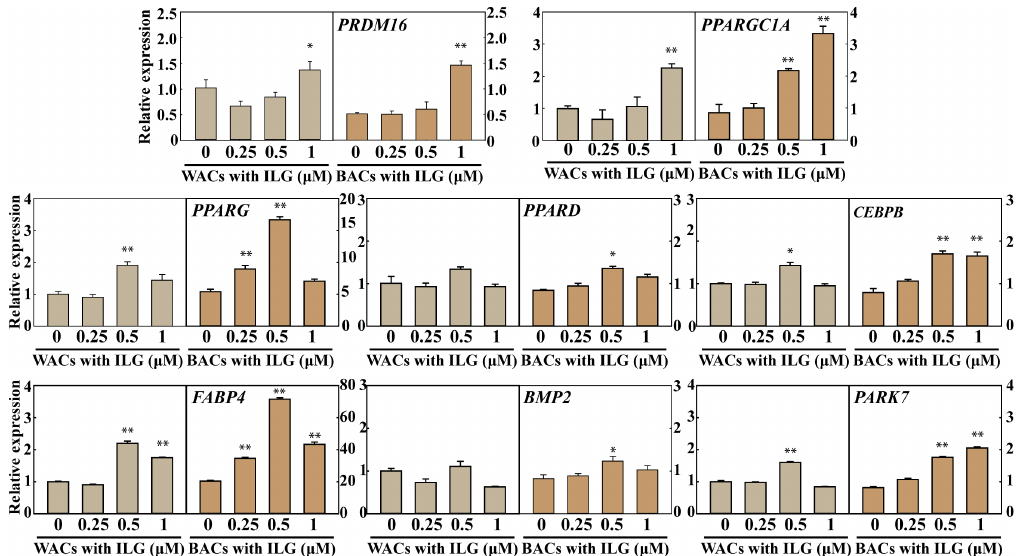
Figure 3. E ff ect of ILG treatment on the mRNA expression of browning markers in WACs and BACs. E ff ect of ILG treatment on the mRNA expression of browning markers in WACs and BACs. Quantitative real-time PCR analysis of the PPARGC1A , PPARG , PPARD , CEBPB , FABP4 , BMP2 , and PARK7 genes in cells treated with ILG for 24 h after adipogenic di ff erentiation. GAPDH was used as an internal control to normalize the expression of the target genes; n = 3 independent experiments; * p < 0.05 and ** p < 0.01.